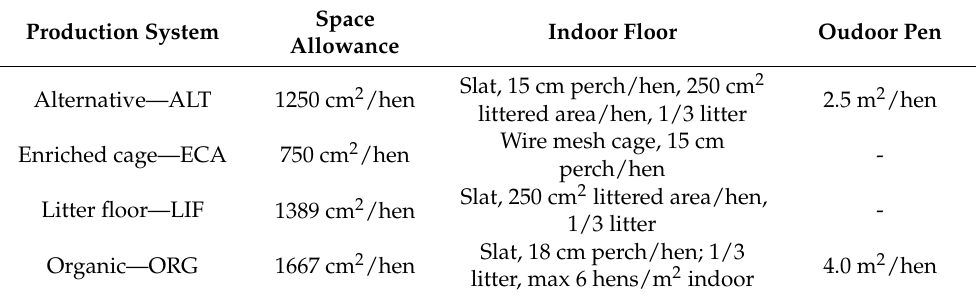
Table 1. Housing characteristics according to Council Directive 1999/74/EC laying down minimum standards for the protection of laying hens; Council Regulation 2007/834/EC and Commission Regulation 2008/889/EC about organic production and labelling of organic products. Production